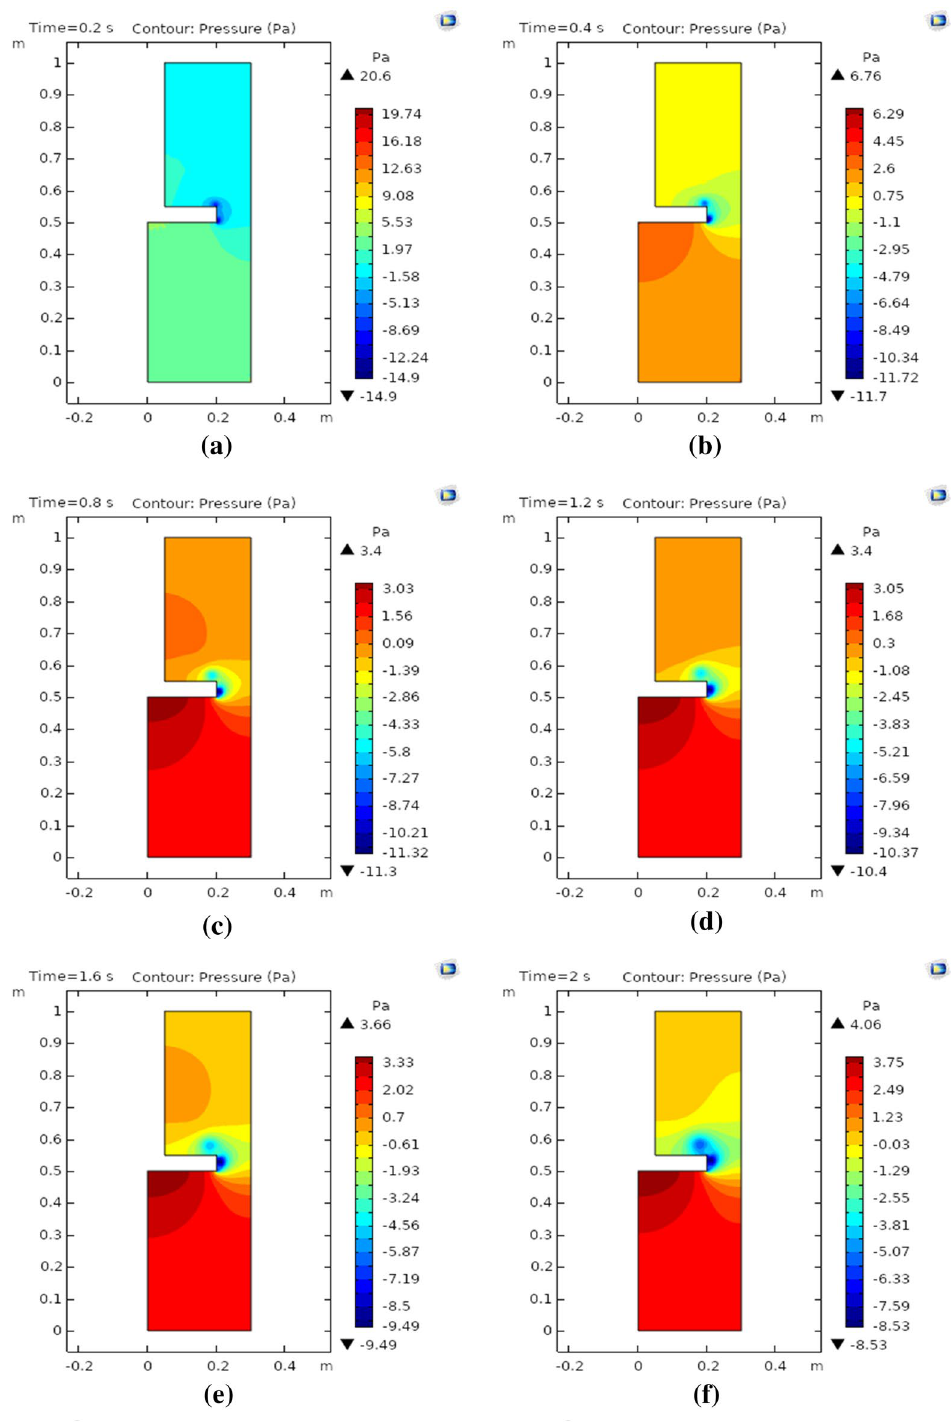
Figure 4. (a) Pressure contours at 0.2 s, ( b) pressure contours at 0.4 s, ( c) pressure contours at 0.8 s, ( d) pressure contours at 1.2 s, € pressure contours at 1.6 s, ( f) pressure contours at 2.0